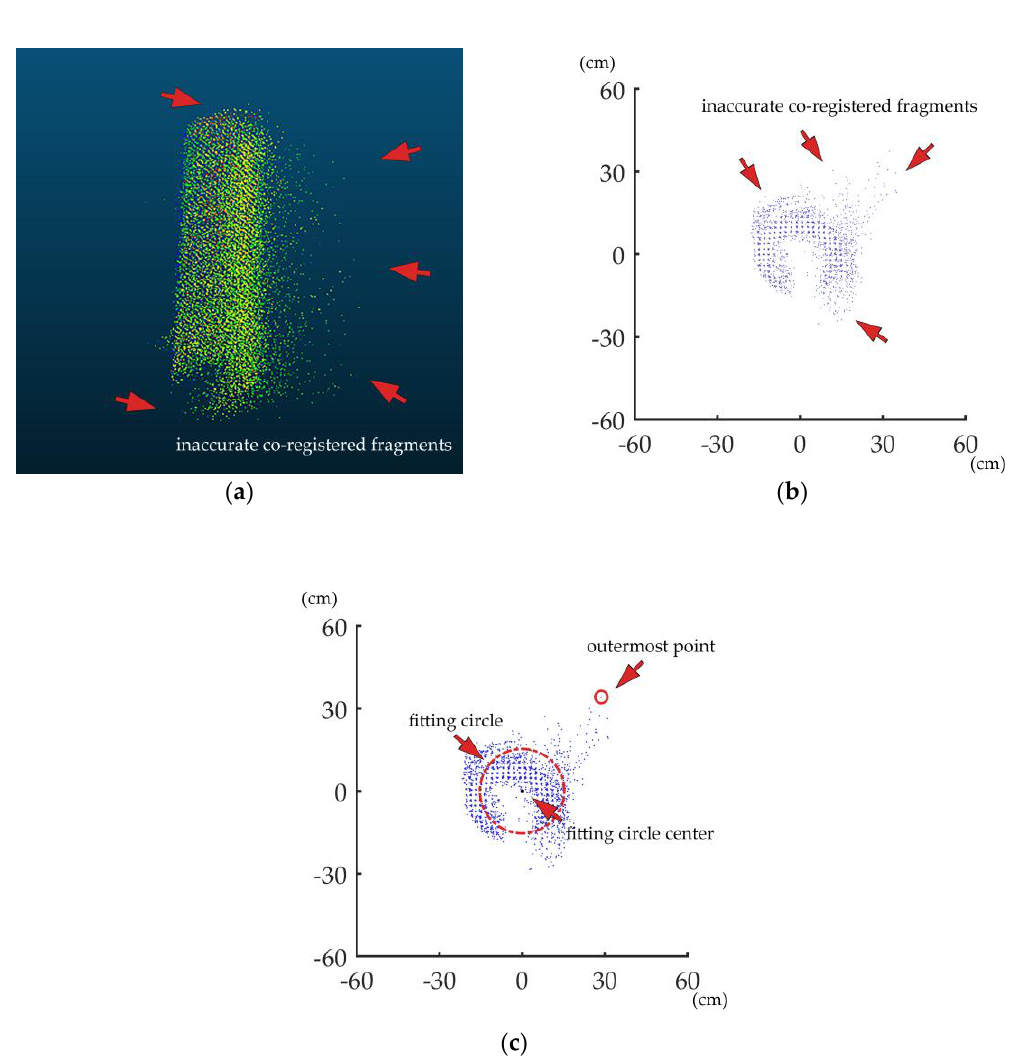
Figure 5. A PLS-based horizontal projected stem point cloud with inaccurately co-registered fragments ( a ) in 3D view and ( b ) in the top view and ( c ) the identification of the outermost